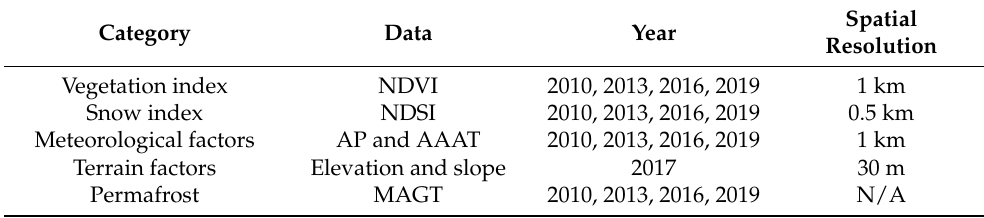
Table 1. List of the data in this